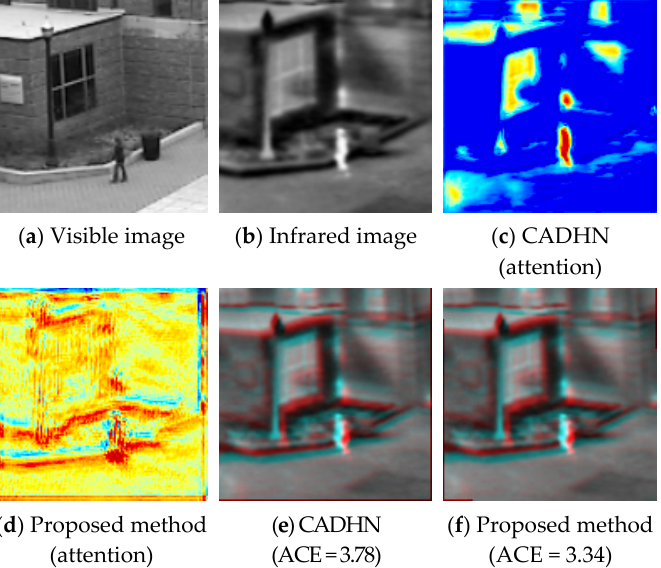
Figure 1. Homography estimation for infrared and visible images. We propose a detail-aware deep homography estimation method to obtain detailed information in images and reduce matching errors. ( a , b ) Input image pairs. ( c , d ) The results of visualizing attention in the different network using Grad-CAM [45]. ( e , f ) The results of fusing the blue and green channels of the warped infrared image with the red channel of the ground-truth infrared image and computing the corresponding average corner error (ACE) [41].